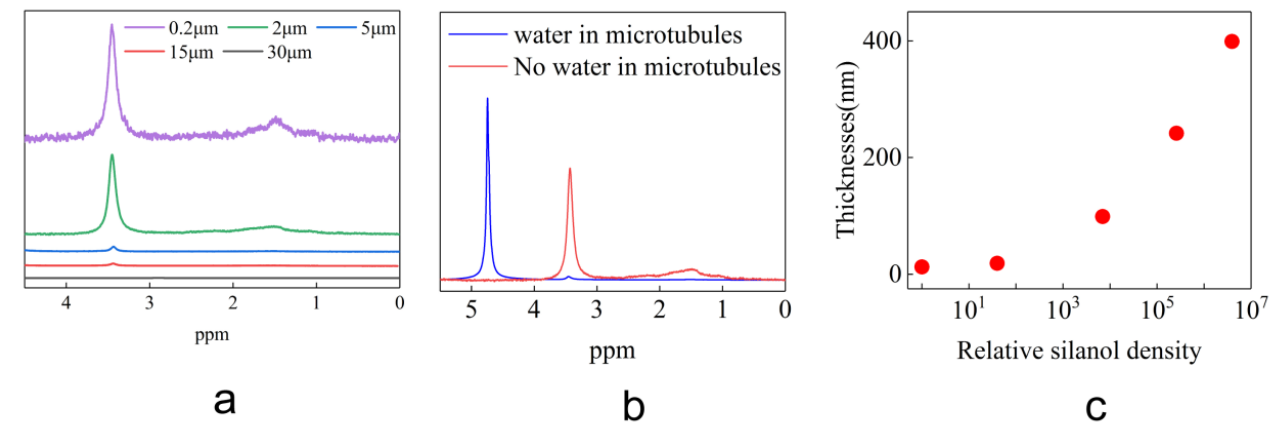
Figure 7. Distribution of Silanol Content on Microtubule Surface. ( a ) shows the H-NMR spectral data of the silica microtubule of different ID sizes for which the peak area characterizes the quantities of the silanol groups. ( b ) shows the H-NMR spectral data of empty silica microtubules and water-filled microtubules. ( c ) shows the relationship between the relative silanol density and the thickness of wall-bound water layer and the signal intensity of the H-spectrum for microtubules with different ID sizes based on the silanol density found within glass microtubule 30 µ m in ID.